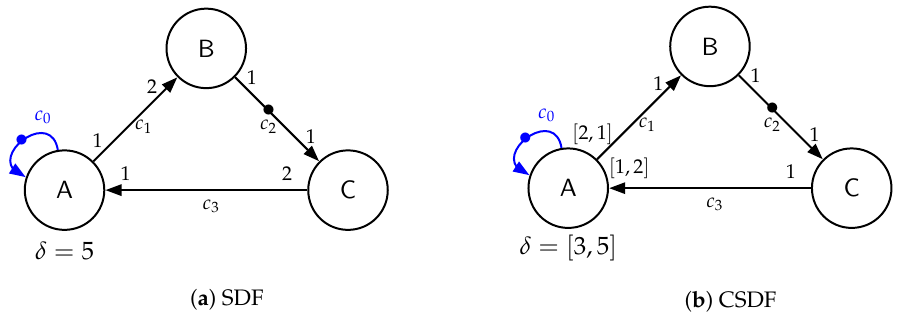
Figure 2. Examples of synchronous dataflow (SDF) and cyclo-static dataflow (CSDF) graphs. Definition 2. Actor